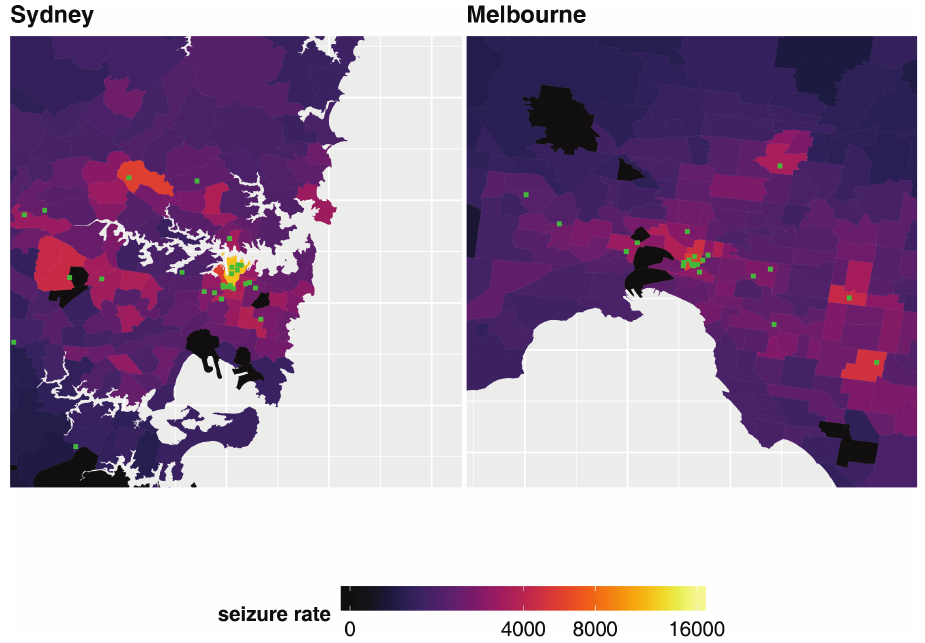
Figure 1. Seizure rate patterns by SA2 polygon for Sydney and Melbourne, per 100,000 people from 2008-2011. Green squares correspond to locations of university